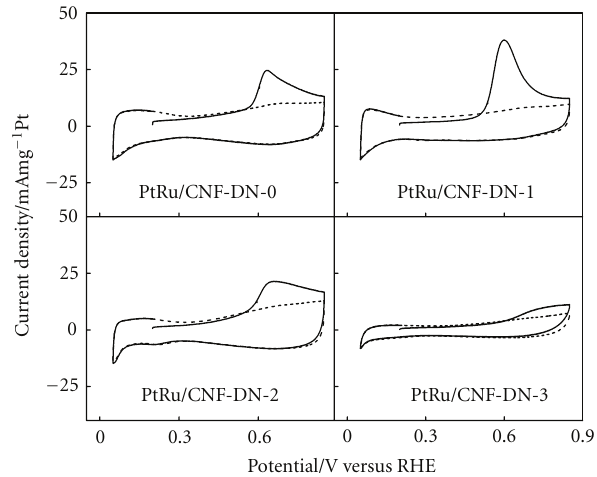
Figure 4: Cyclic voltammograms for CO oxidation at room temperature on untreated synthesized catalysts. Full line: first scan. Dashed line: second scan. Scan rate: 20mVs − 1 . Supporting electrolyte: 0.5 M H 2 SO 4 . CO adsorption potential: 0.2V versus RHE.